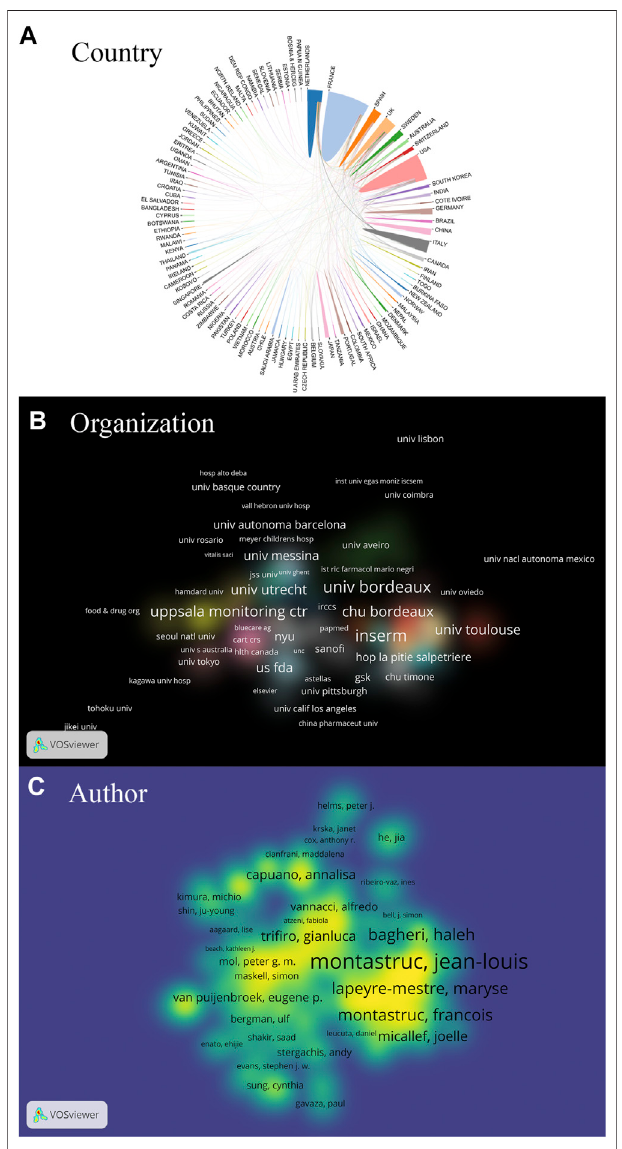
FIGURE2| Thecoauthorshipintermsofcountries (A) ,organizations (B) and authors (C) on pharmacovigilance from 1974 to 2021. The collaborative strength of countries is indicated by the circle area in Figure 2A . The coauthorship strength of organizations and authors is expressed by the label size in the brightened area of Figures 2B,C , respectively. The smaller distance between the two items re fl ects the stronger relation.